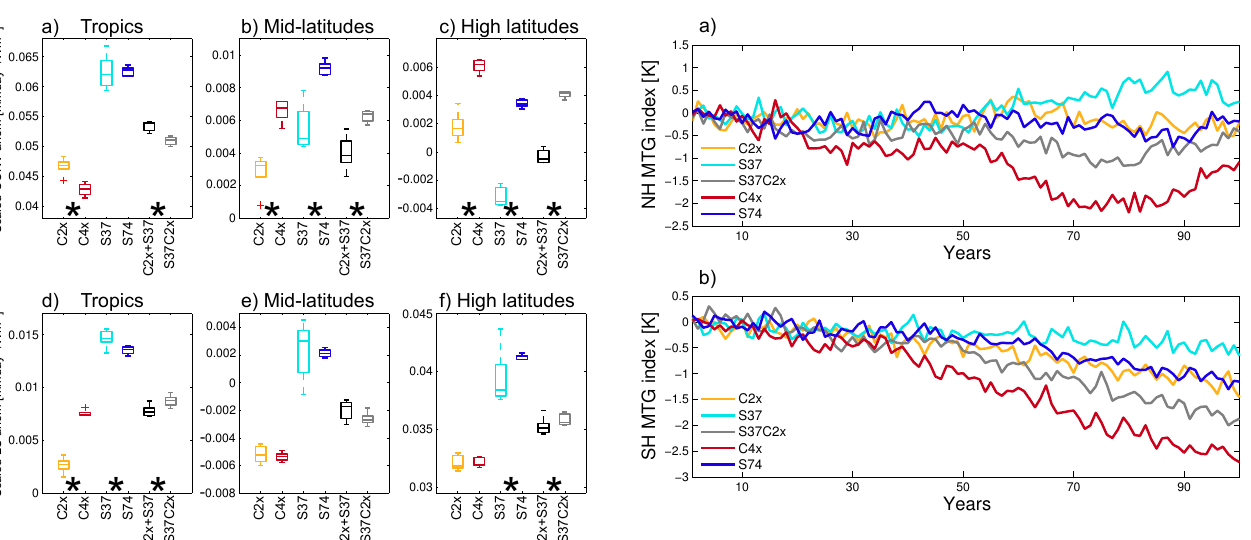
Fig. 6. Annual mean meridional surface air temperature gradient calculated as the difference between 15 ◦ S–15 ◦ N and 90 ◦ N–50 ◦ N or 50 ◦ S–90 ◦ S for (a) the Northern (NH) or (b) the Southern Hemisphere (SH) for all five scenarios. Averages over the five ensemble members are shown.